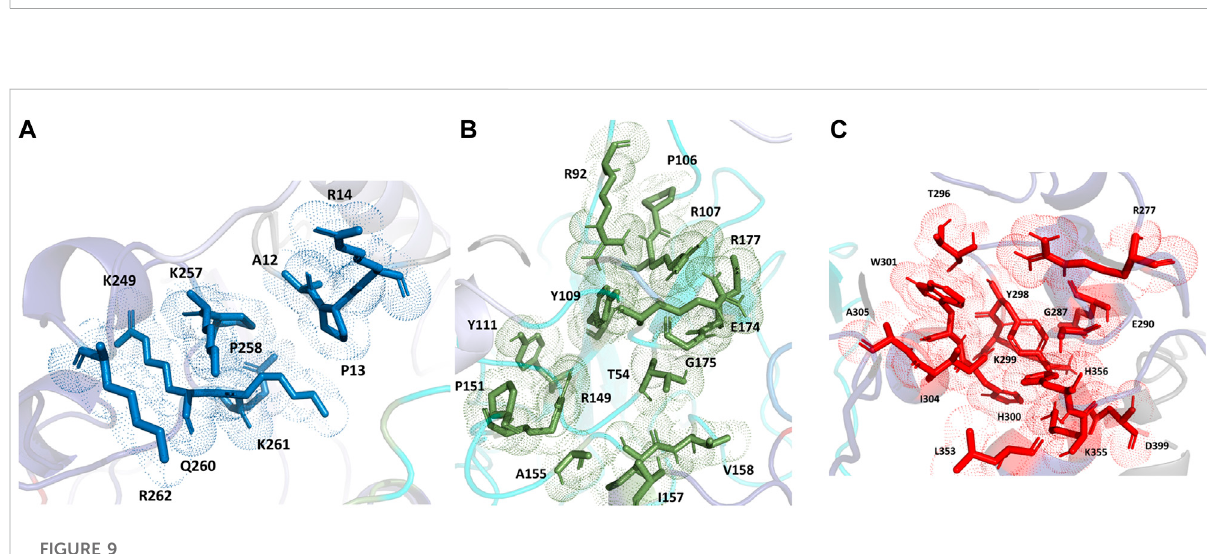
D399. For the N-terminus model of Nucleocapsid protein, POOL predicts the following residues (Figure 10): T49, A50, S51, V72, P73, Y86, Y87, R88, R92, R107, Y109, F110, Y111, Y112, and R149. For the C-terminus Nucleocapsid protein structure (PDB ID: 7DE1), the POOL predicted residues are (Figure 10): R259, R262, R277, D288, Y298, K299, H300, W301, I304, A305, K355, and H356. For the SARS-CoV-2 N-terminal domain of the nucleocapsid protein, it has been reported that residues R92, R107, Y109 and R149 interact with the RNA (Dinesh et al., 2020); these residues are included in the POOL predictions for both the full-length N protein (Site 2) and the N-terminus model structure. We note that the POOL